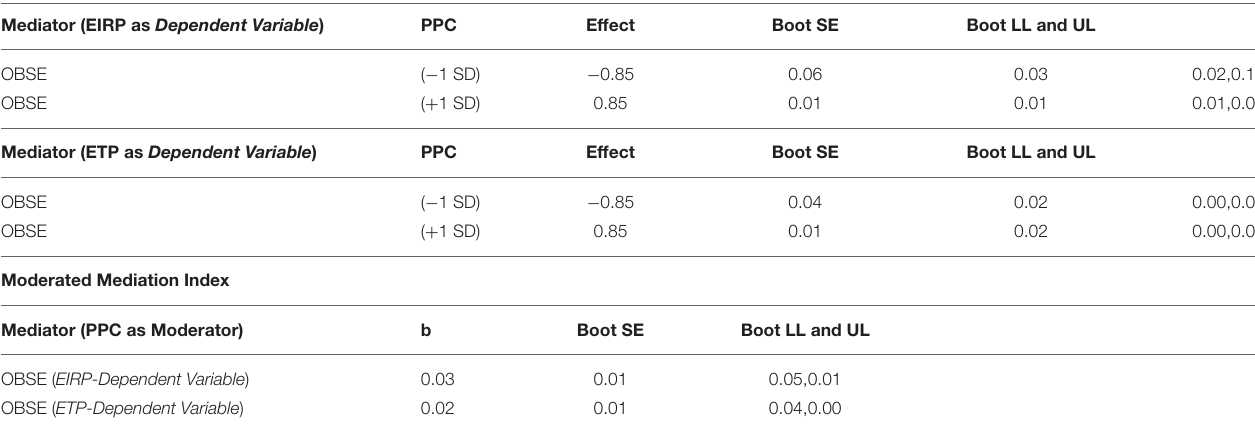
TABLE 4 | Conditional indirect effects (PPC as moderator). Mediator (EIRP as Dependent Variable